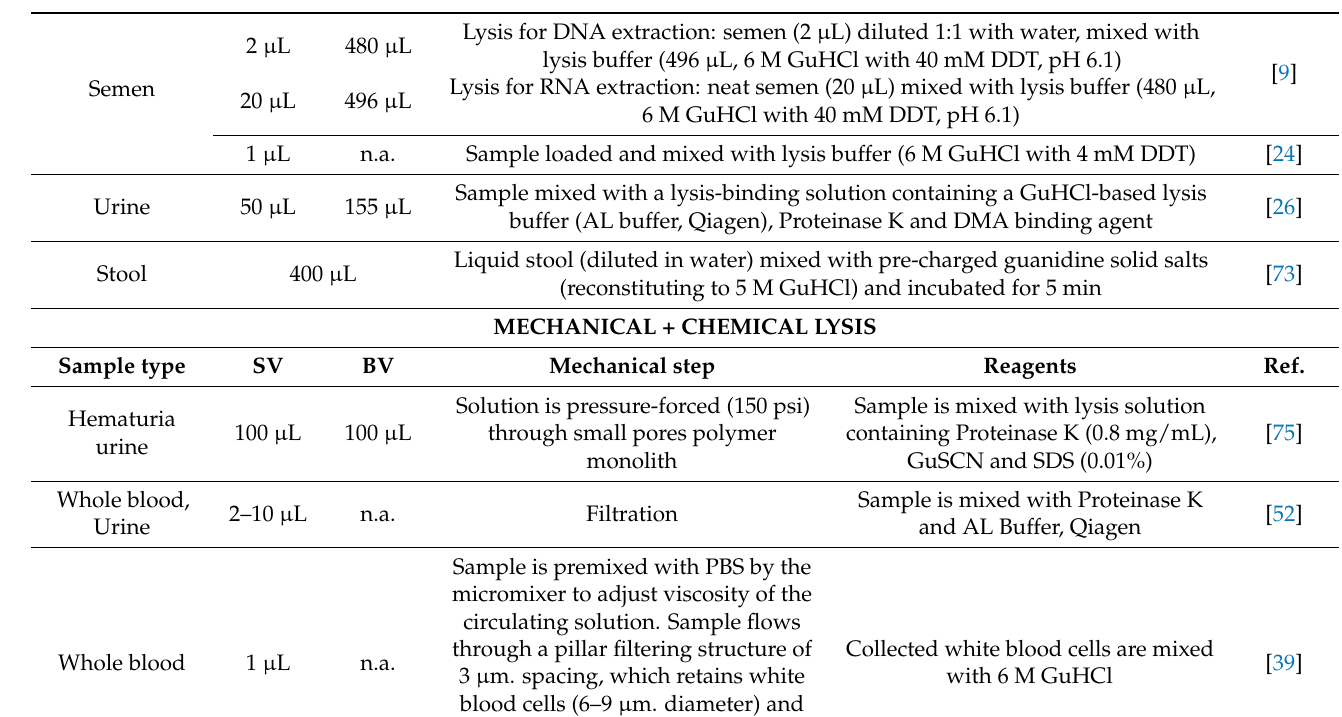
Table 2. Cont. Lysis for DNA extraction: semen (2 µ L) diluted 1:1 with water, mixed